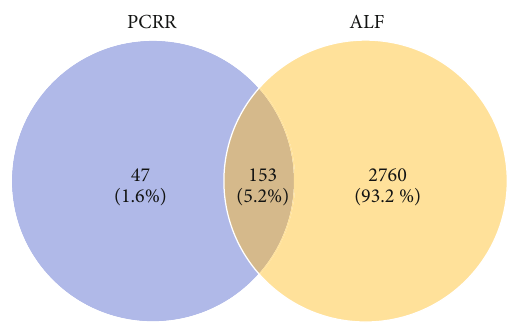
Figure 2: The candidate target genes of Polygoni Cuspidati Rhizoma et Radix (PCRR) and/or in acute liver failure